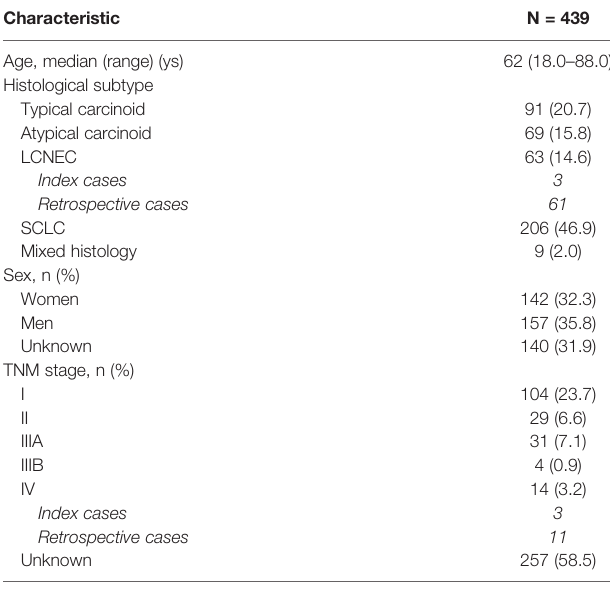
TABLE 1 | Clinicopathological characteristics of the global cohort [retrospective cases (n = 436) and patient index cases (n = 3)]. Characteristic